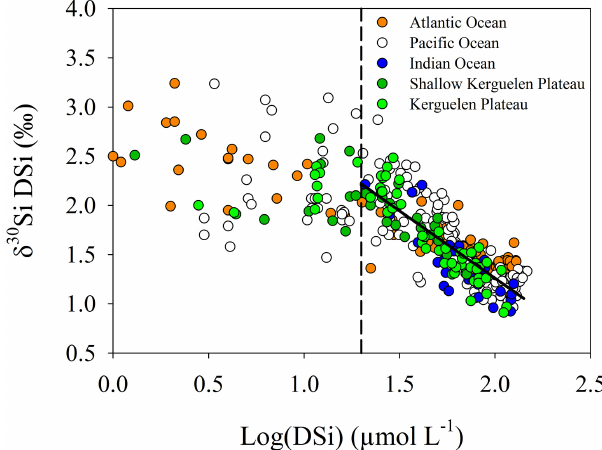
Fig. 4. The δ 30 Si DSi versus the Log(DSi) of samples from the Southern Ocean from the Atlantic sector and the Indian sector (this study and De La Rocha et al., 2011; Fripiat et al., 2011a; de Souza et al., 2012b), the Kerguelen Plateau (De La Rocha et al., 2011; Fripiat et al., 2011b), and the Pacific sector (Varela et al., 2004; Cardinal et al., 2005; Cardinal et al., 2007). The dotted line occurs at a DSi concentration of 20µM and the solid line is the regression line for the data, except for the samples from the Kerguelen Plateau and from Cardinal et al. (2005), which are outliers ( y 0 = − 1 . 37 x + 4 . 00, R 2 = 0 . 64 for p < 0 . adjusted